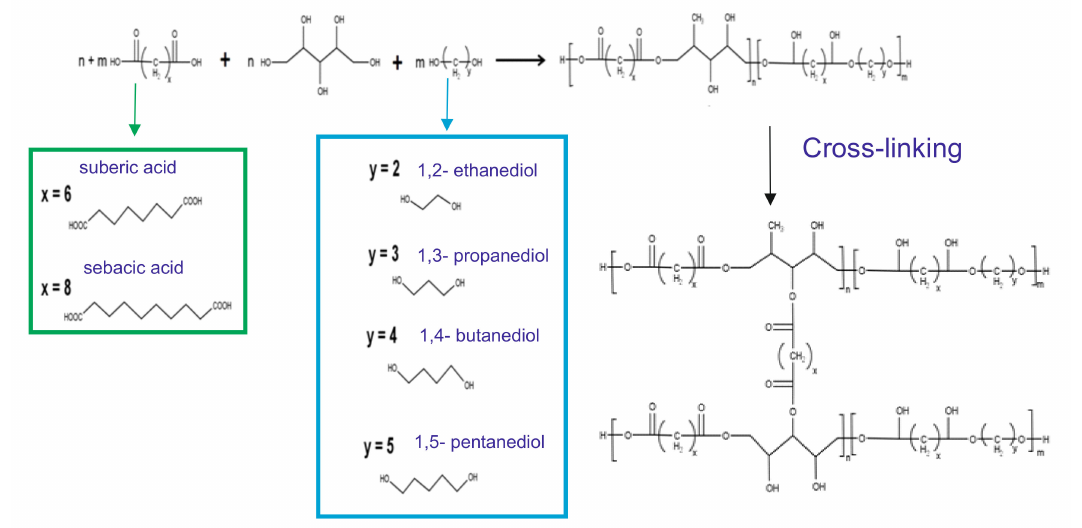
Figure 1. Scheme of the poly(xylitol dicarboxylate-co-diol dicarboxylate)